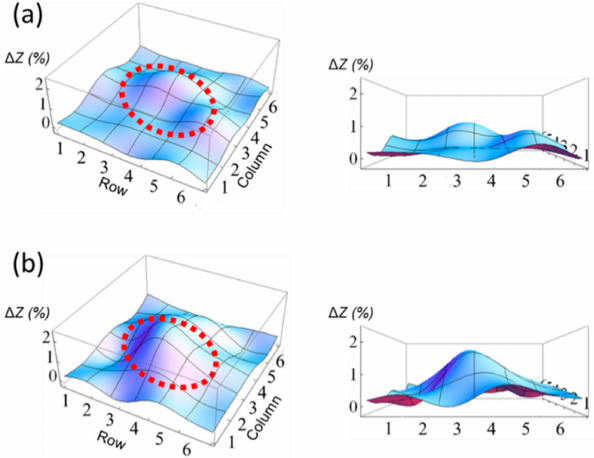
Figure 5. Elasticity sensing test results using the 6 × 6 sensor array for ( a ) 5% WR gelatin sample and ( b ) 30% WR gelatin sample. Red dotted circles represent the position of each gelatin